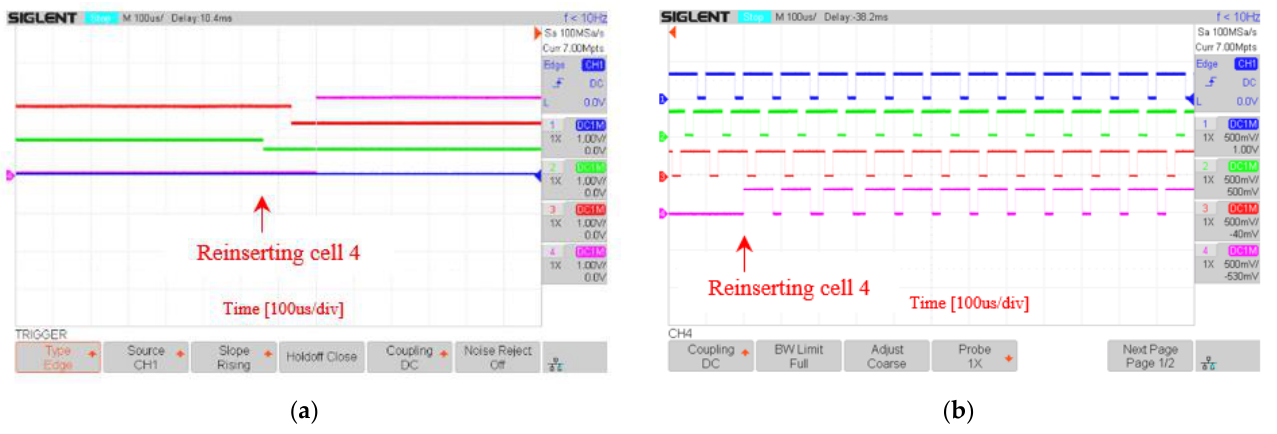
Figure 35. The system response when reinserting cell 4, ( a ) carrier phases; ( b ) PWM control signals.